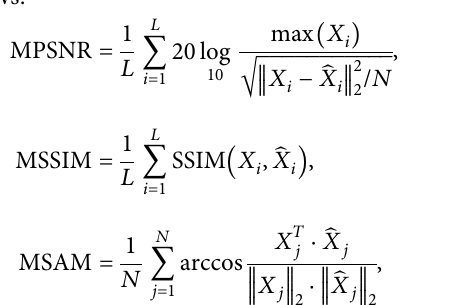
Figure 3: Original abundance map and maps obtained by difference operation. (a) Abundance map; (b) horizontal gradient map ( D (c) vertical gradient map ( D v S ); (d) vertical difference on (b) ( D v D h S ); and (e) comparison of three various